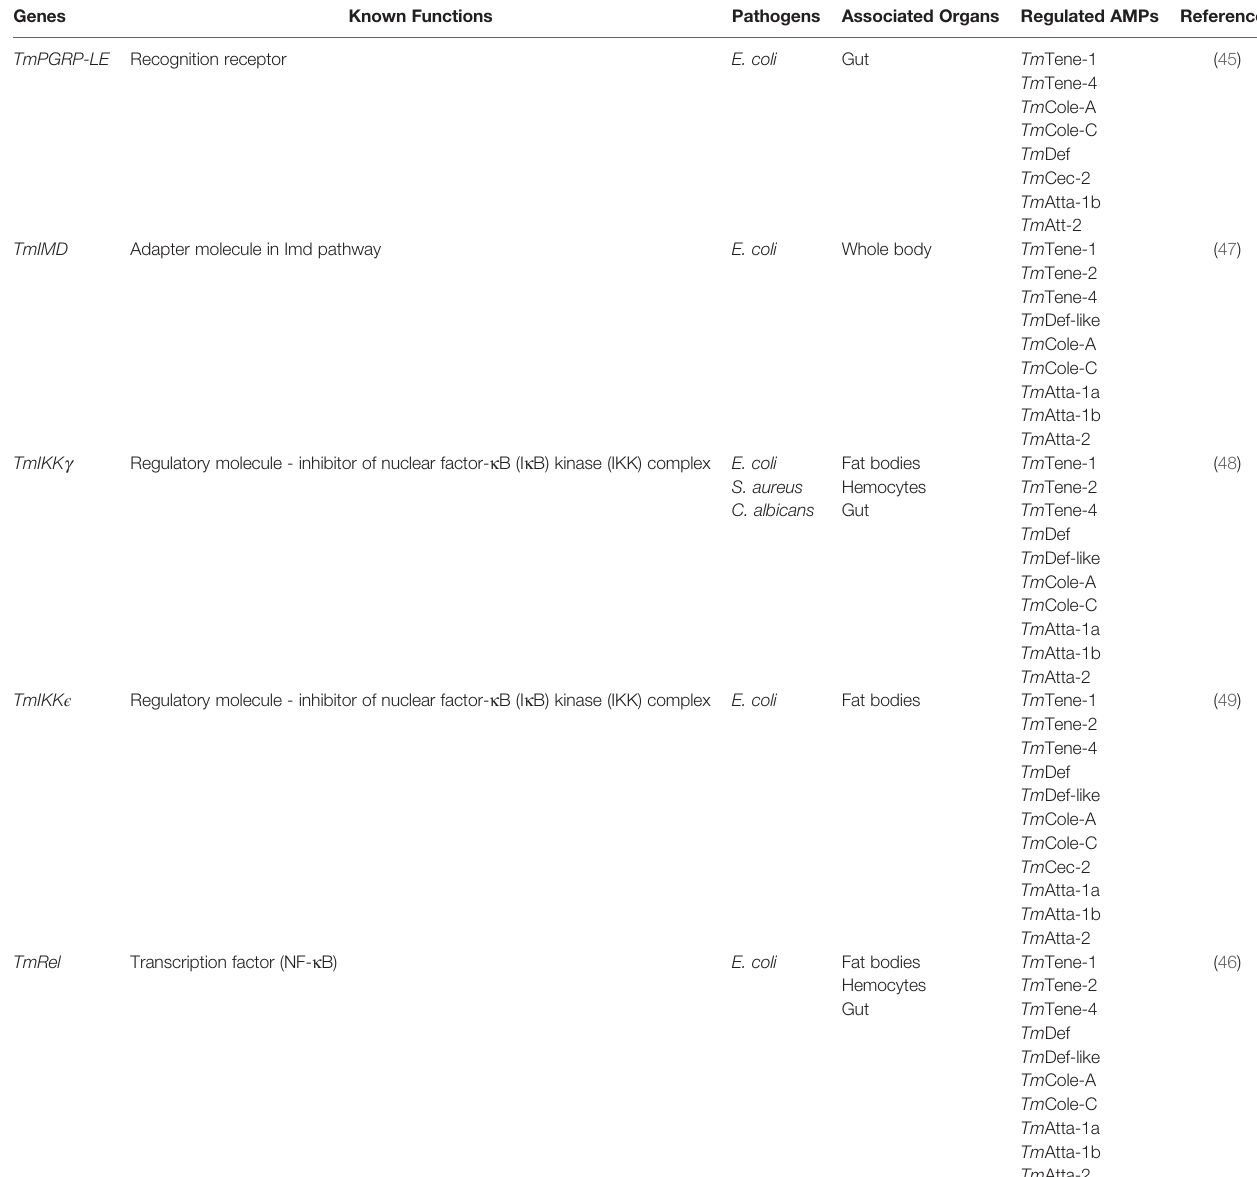
TABLE 1 | Summary of the Imd pathway compartments that regulate antimicrobial peptide production in T. molitor . Genes Known Functions Pathogens Associated Organs Regulated AMPs References TmPGRP-LE Recognition